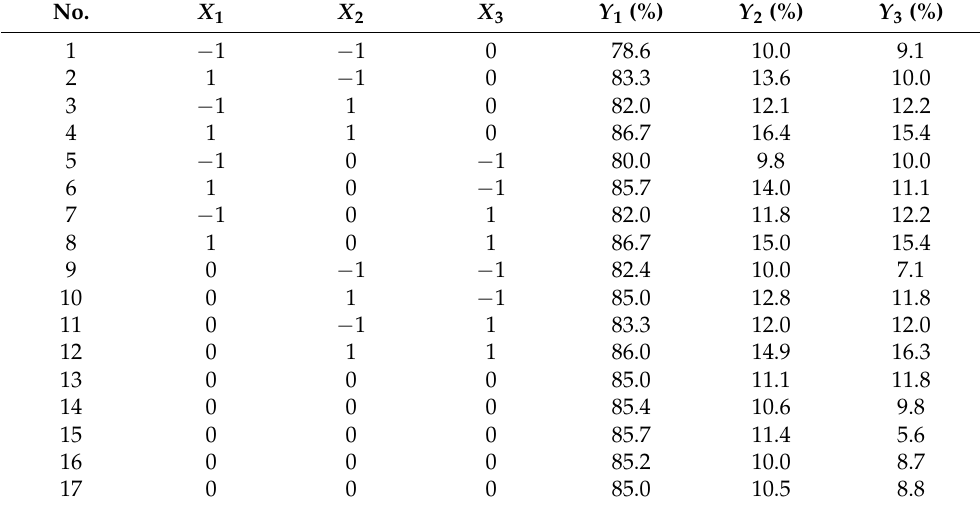
Table 2. The experimental schemes and results.